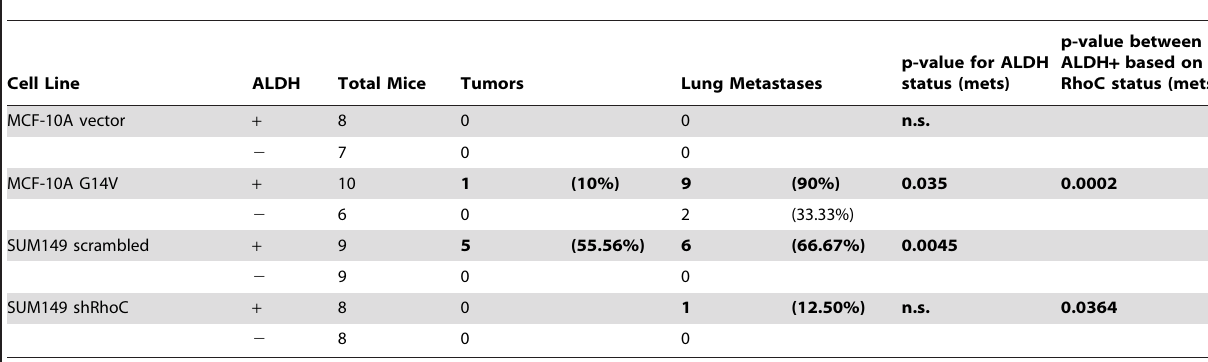
Table 1. Analysis of xenografted